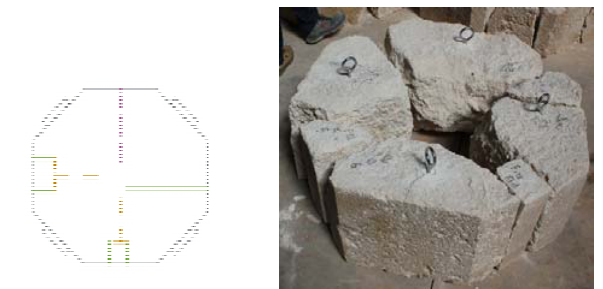
Figure 11. Pillar n. 12 – row III. On the left, diagnostic drawing; on the right the ashlars disassemble and reassemble on the floor.